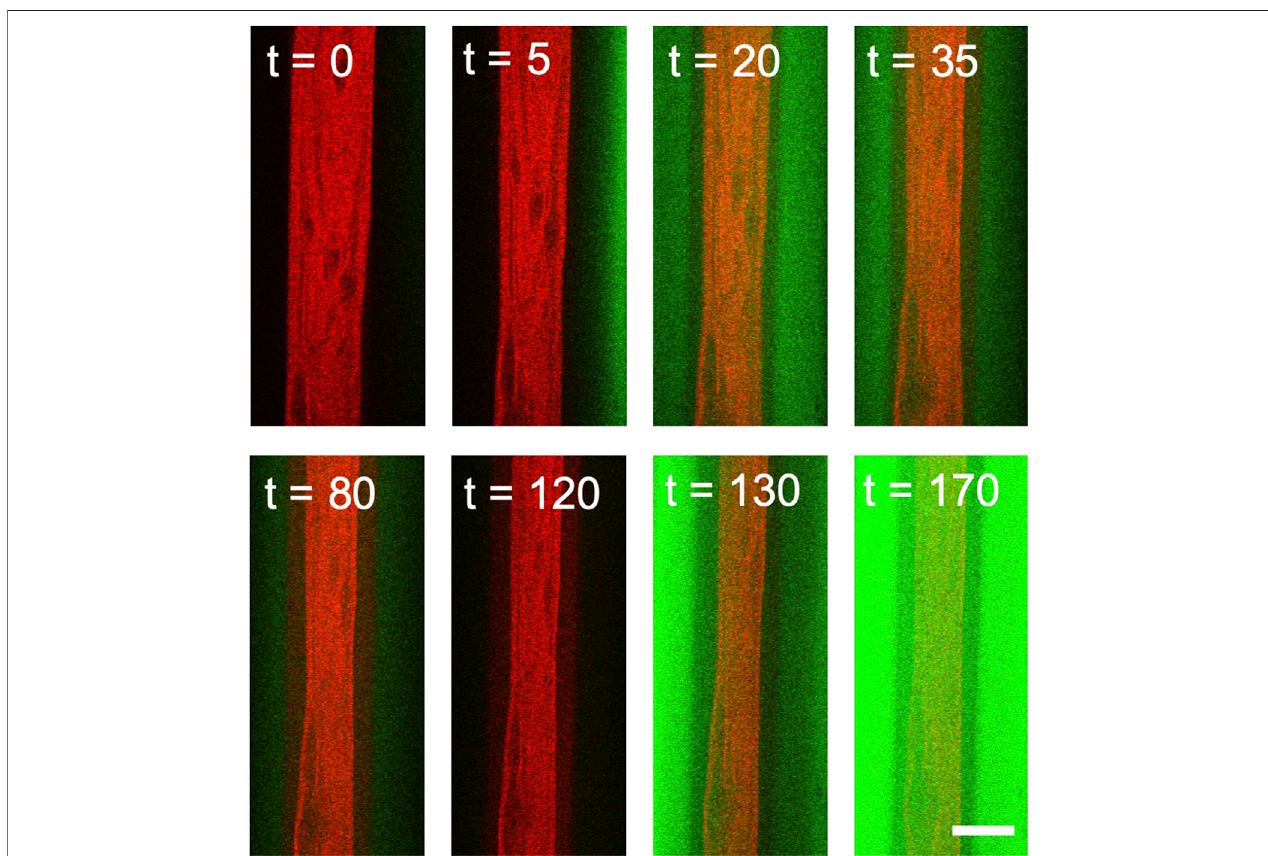
FIGURE 2 | Two-color confocal imaging of actin network undergoing contraction triggered by variation in Mg 2+ concentration. Two-color laser scanning confocal images of an actin network (red) as the Mg 2+ concentration slowly varies from 2 mM (green) to 20 mM (black) and back to 2 mM (green). Fluorescein in the 2 mM Mg 2+ buffer(butnotinthe20 mMMg 2+ buffer)isusedtoquantifytheMg 2+ concentrationasafunctionoftime.Becauseittakes ∼ 5 minforthebufferfromthereservoirtoenter thesamplechannel,thebufferchannelsinthe fi rstfewimagesareblackdespitebeingat2 mMMg 2+ .Att (cid:2) 30min,the20 mMMg 2+ solutionisintroduced,whichis seenasthegreensignalintensitydecayingtoblack.Att (cid:2) 120min,the2 mMMg 2+ solutionisreintroduced,viewedasincreasingintensityinthegreenchannel.Scalebar is 500 μ m and time is in